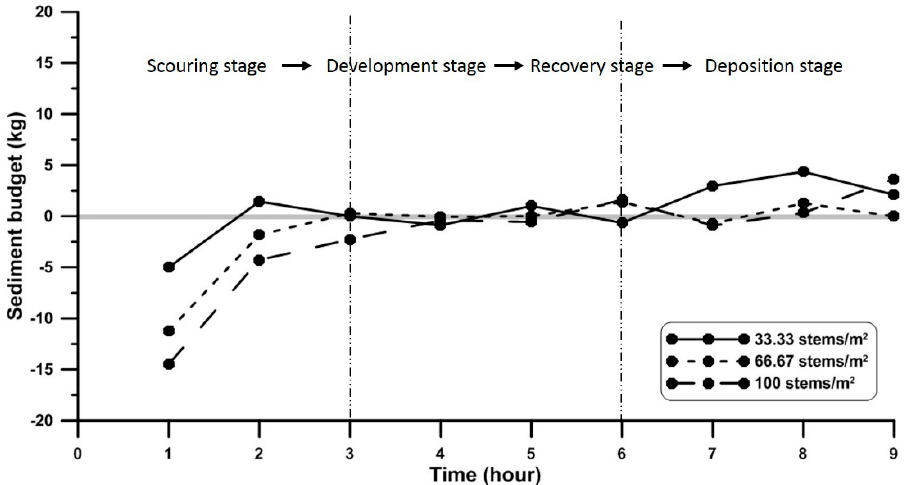
Figure 6. Average amount of hourly sediment budget in 33.33, 66.67, 100 stems/m 2